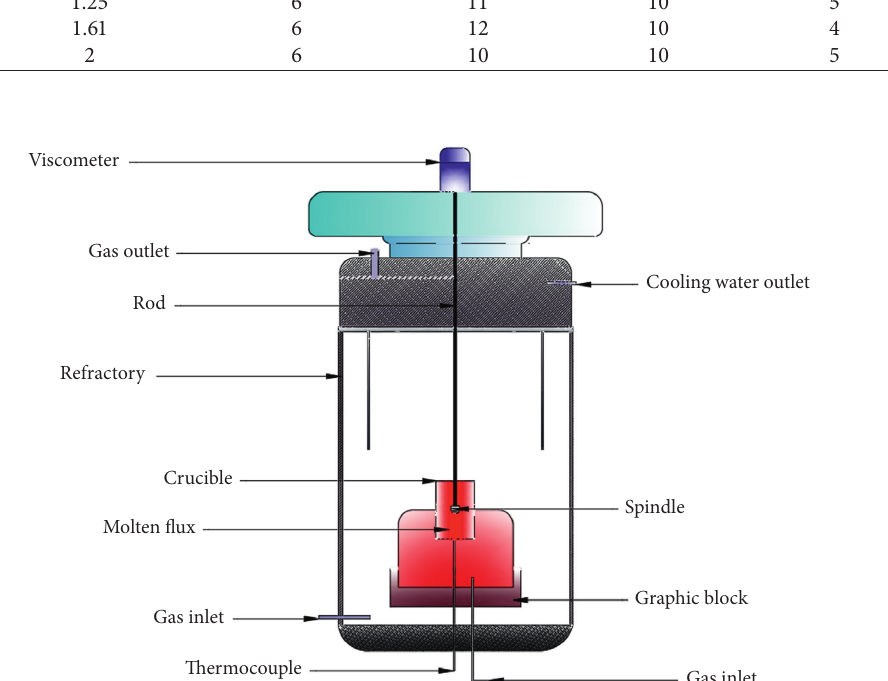
Figure 5: Schematic of the experimental setup.